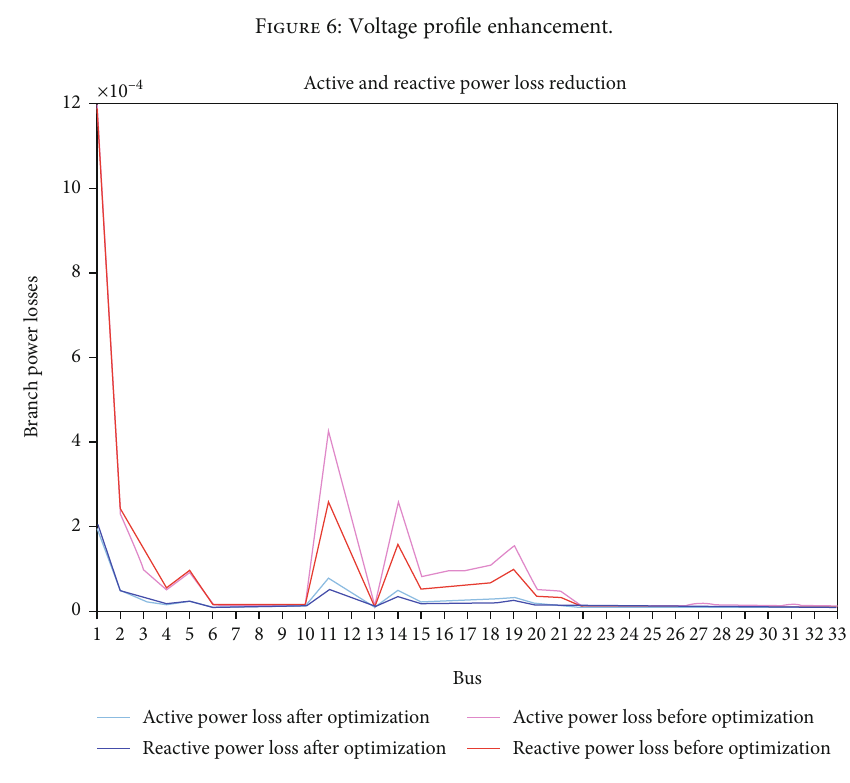
Figure 6: Voltage pro fi le enhancement.